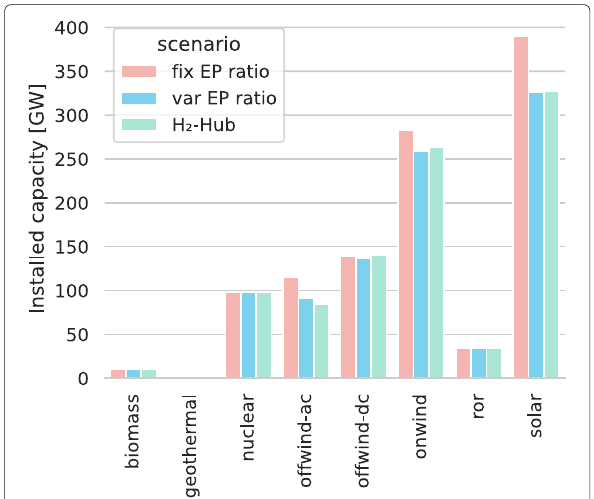
Fig. 6 Optimization result for future installed generation capacity in the exemplary 100% emission reduction scenarios. The abbreviations ’ror’ stands for run of river, offwind-ac and -dc for AC and DC connected offshore wind plants,